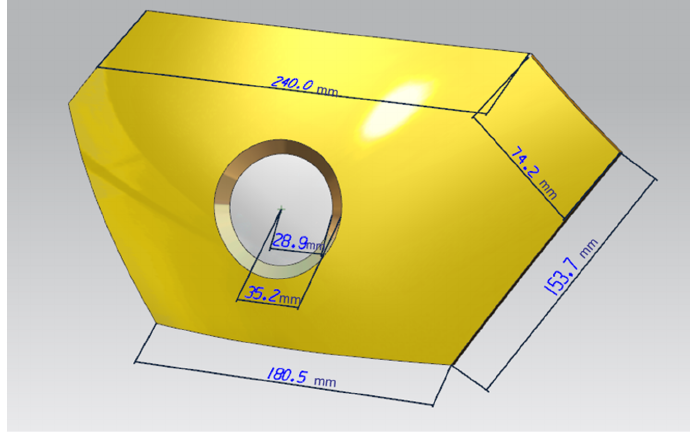
Figure 4. Exterior dimensions of the armor.